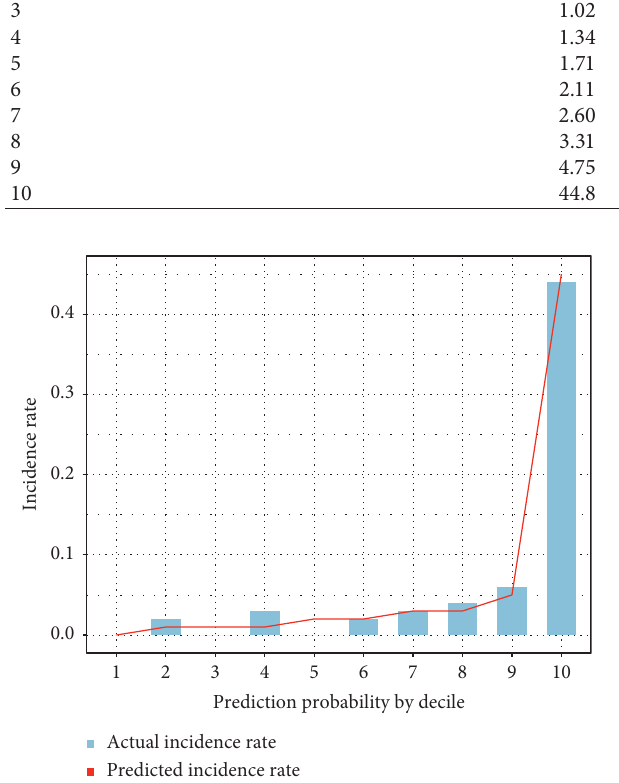
Figure 7: Distribution map of actual incidence rate and predicted incidence rate.